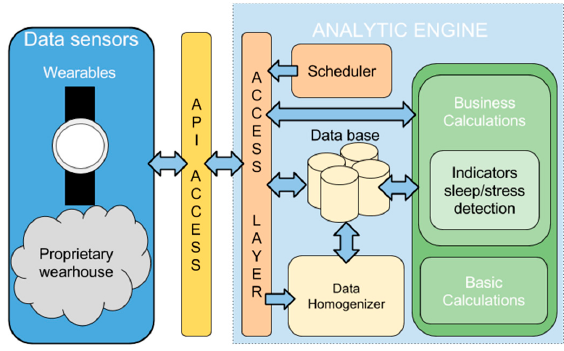
Figure 12. Architecture of our analytic engine.